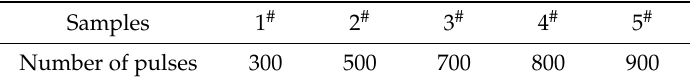
Table 2. Sample numbers and their corresponding pulse